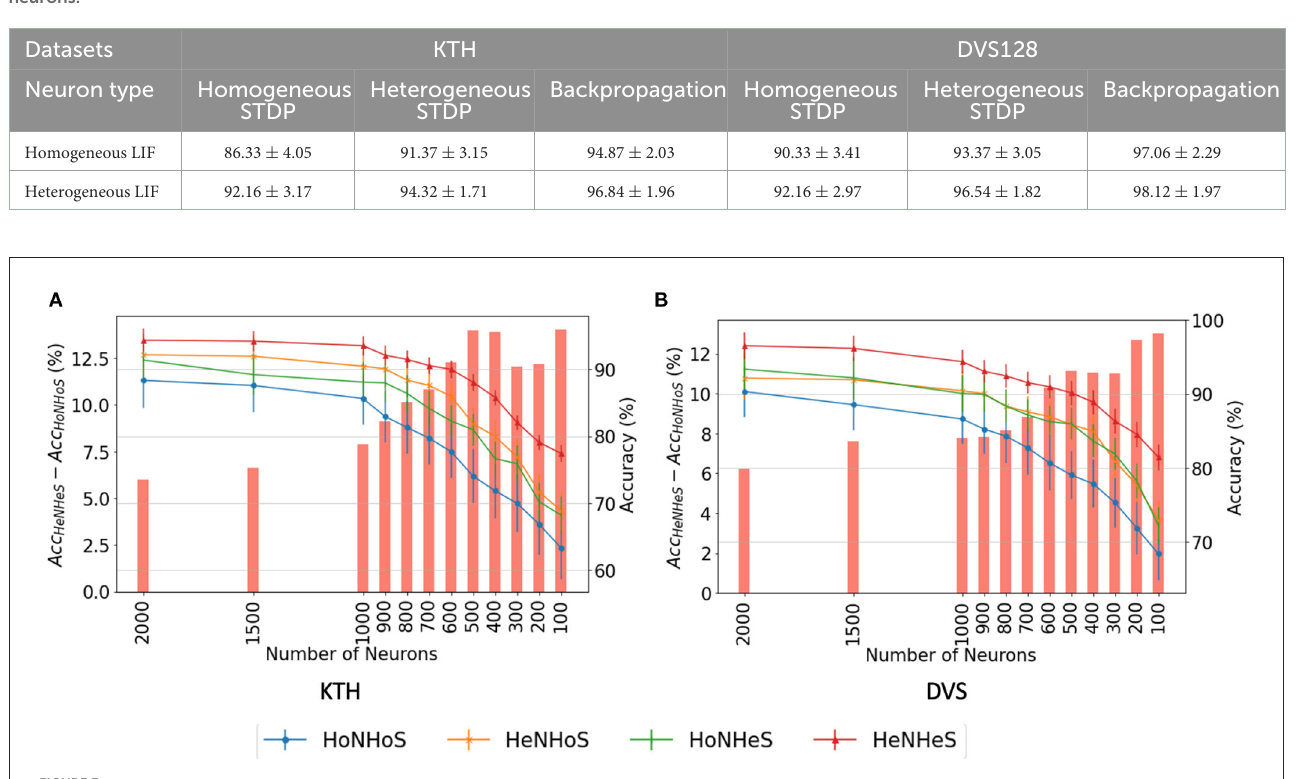
FIGURE3 Comparison of performance of HRSNN models for the (A) KTH dataset and (B) DVS128 dataset for varying number of neurons. The bar graph (left Y-axis) shows the difference between the accuracies between HeNHeS and HoNHoS models. The line graphs (right Y-axis) shows the accuracies (%) for the four ablation networks (HoNHoS, HeNHoS, HoNHeS, and